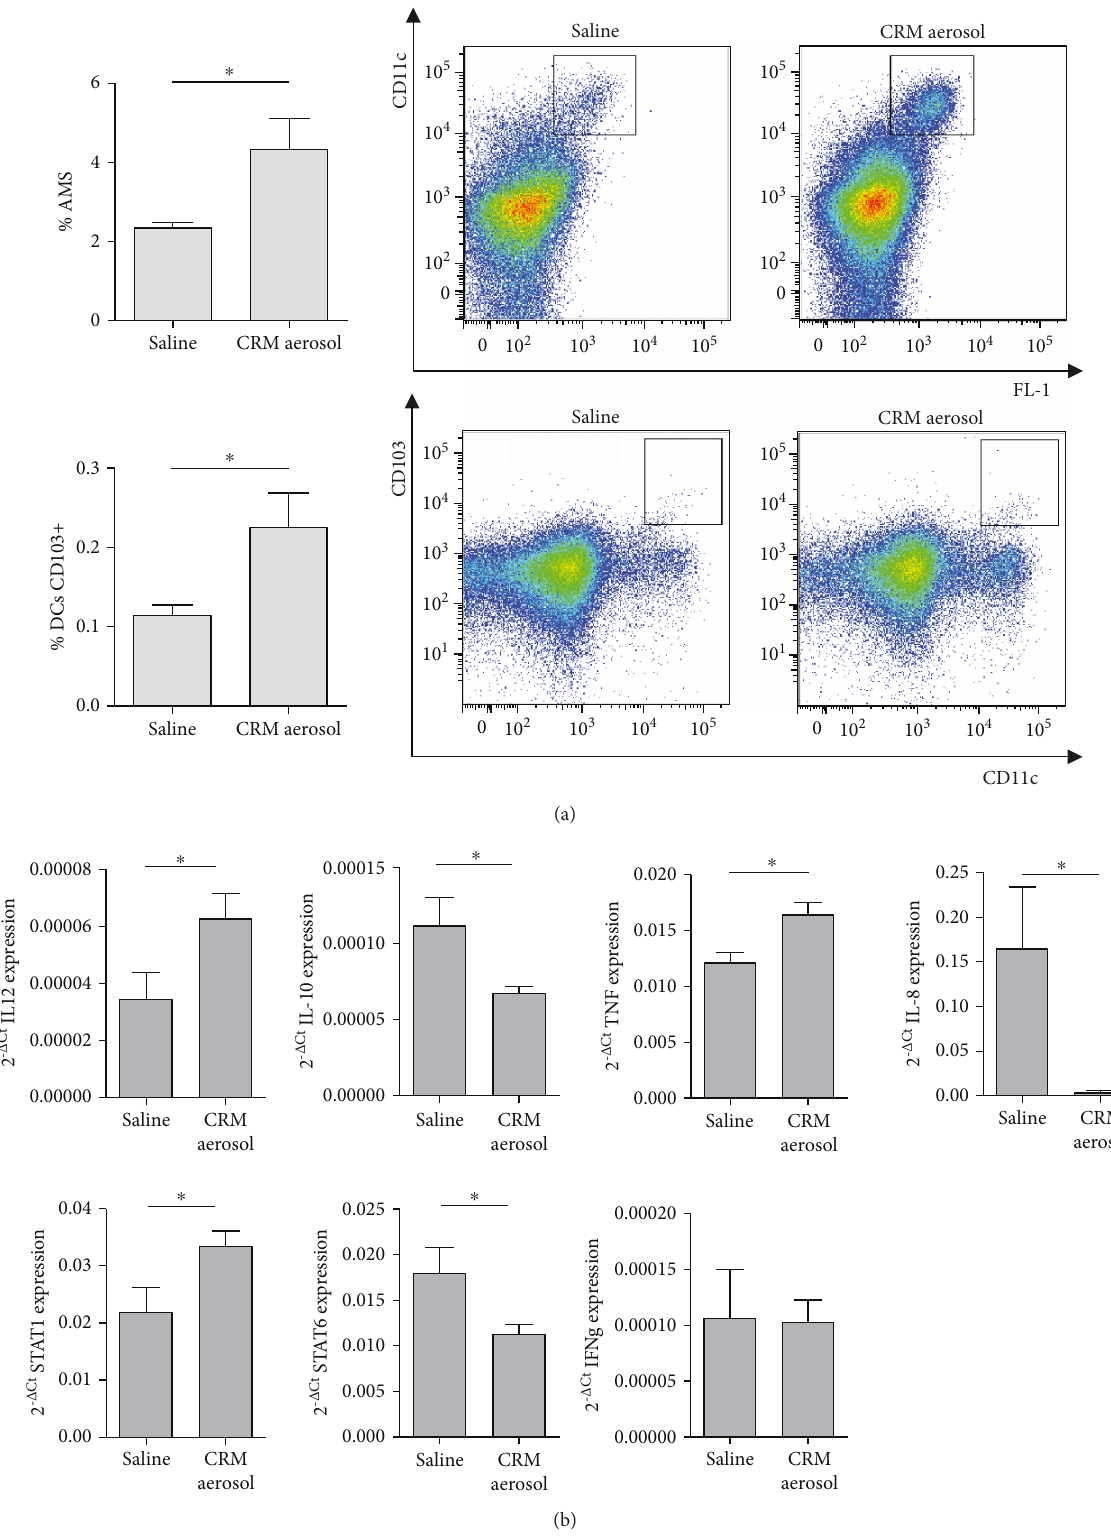
Figure 2: Modi fi cation of lung immune contexture induced by CRM aerosolization. Bars ( mean ± SEM ) and representative dot plots of the percentage of AMs (identi fi ed as CD45+/FL-1+CD11c+ cells) and of CD103+ DCs (identi fi ed as CD45+/CD11b-/CD103+CD11c+ cells) evaluated in lung suspensions of 4 mice/group injected with B16 melanoma cells and aerosolized with saline or combined CRMs (a). Meanrelative expression ± SEM of IL10, IL12, STAT1, STAT6, TNF- α , IFN γ , and IL-8 mRNA levels, evaluated by real-time PCR in adherent cell fraction of digested lungs (4-8 mice/group) (b). Results are presented as 2 - Δ Ct . ∗ p ≤ 0 05 by Student ’ s t